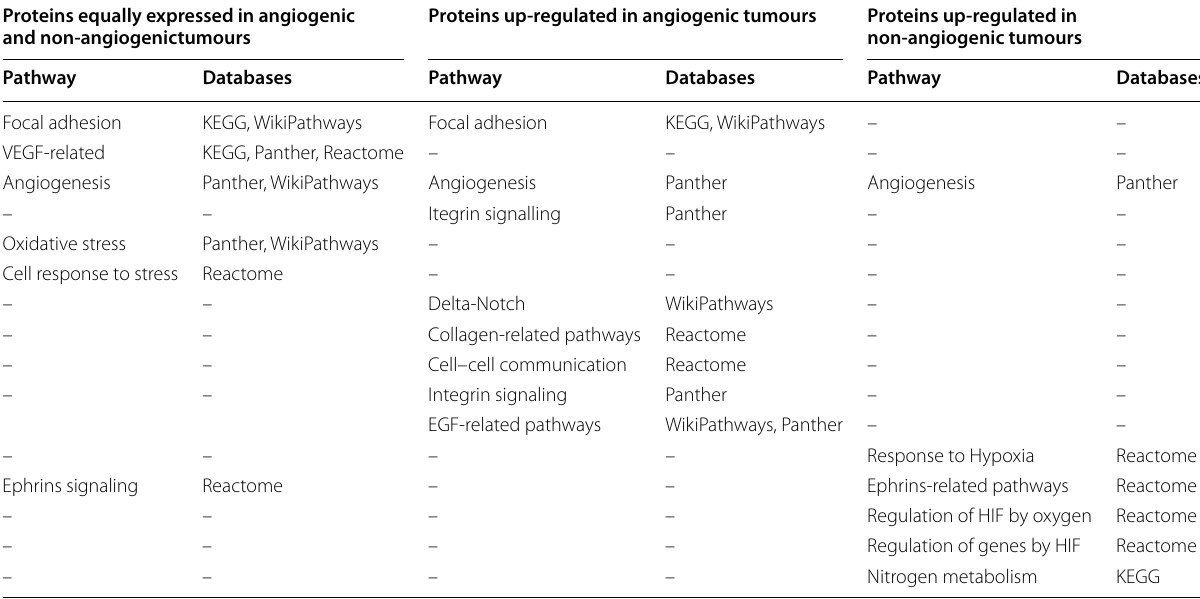
Table 7 Selection of visualized pathways Proteins equally expressed in angiogenic and